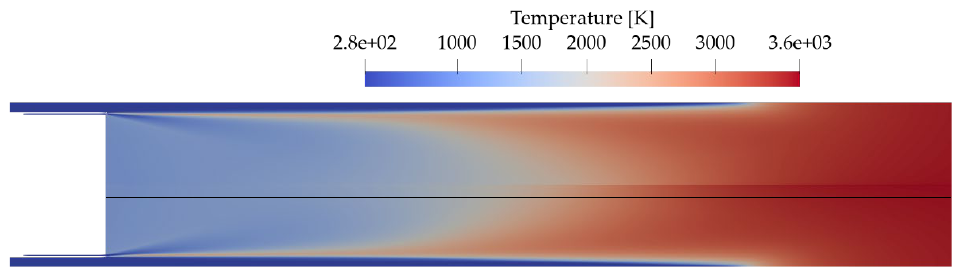
Figure 9. Temperature in the combustion chamber: (top) base—no pollution (rotated with symmetry axis at the top and wall at the bottom), (bottom) All-F pollution. Table 11. Pressure in [MPa] at the chamber wall (x = 0.171 m) for different pollutants of the fuel becomes more visible. In the p10 case the combustion pressure drop is 3.5% (0.36 MPa) and/or the oxidizer at the four pressure sion. Table 11 shows the wall pressure at a position of x = 0.171 m from the injector. This corresponds to the spot where the pressure maximum at the chamber wall is located. Fig- ure 10a–d shows the wall pressure profiles for the different compositions at the four re- spective pressure levels.